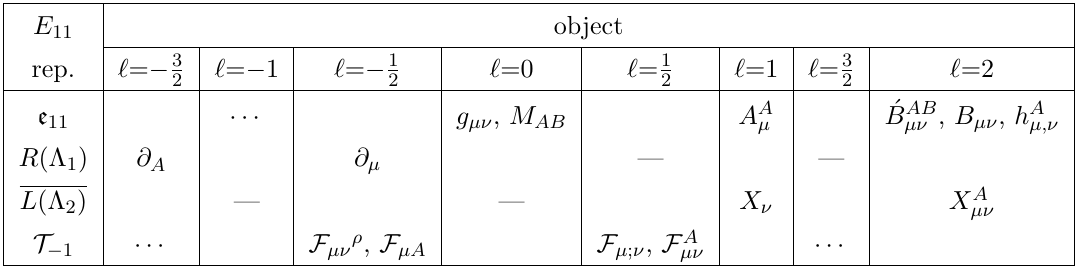
Table 4 . The lowest level components of the various objects of E 11 exceptional field theory in GL(3) × E decomposition. Dashes indicate that there is no GL(3) × E 8 level (since these are parts of highest/lowest weight e there are representations but they play no rôle in our